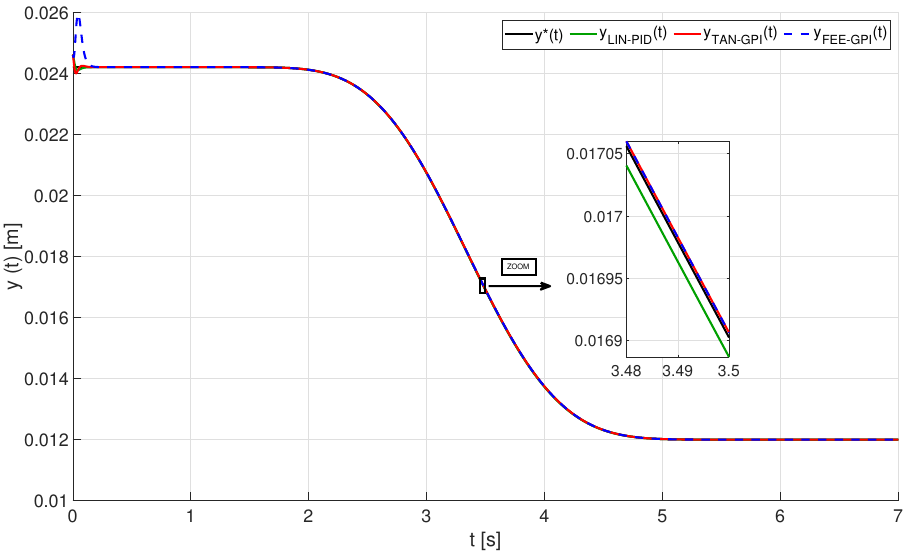
Figure 3. Evolution of the tracking trajectory of the magnetic ball, y ∗ ( t )[ m ] vs. y ( t )[ m ] , nominal case (Test 1).